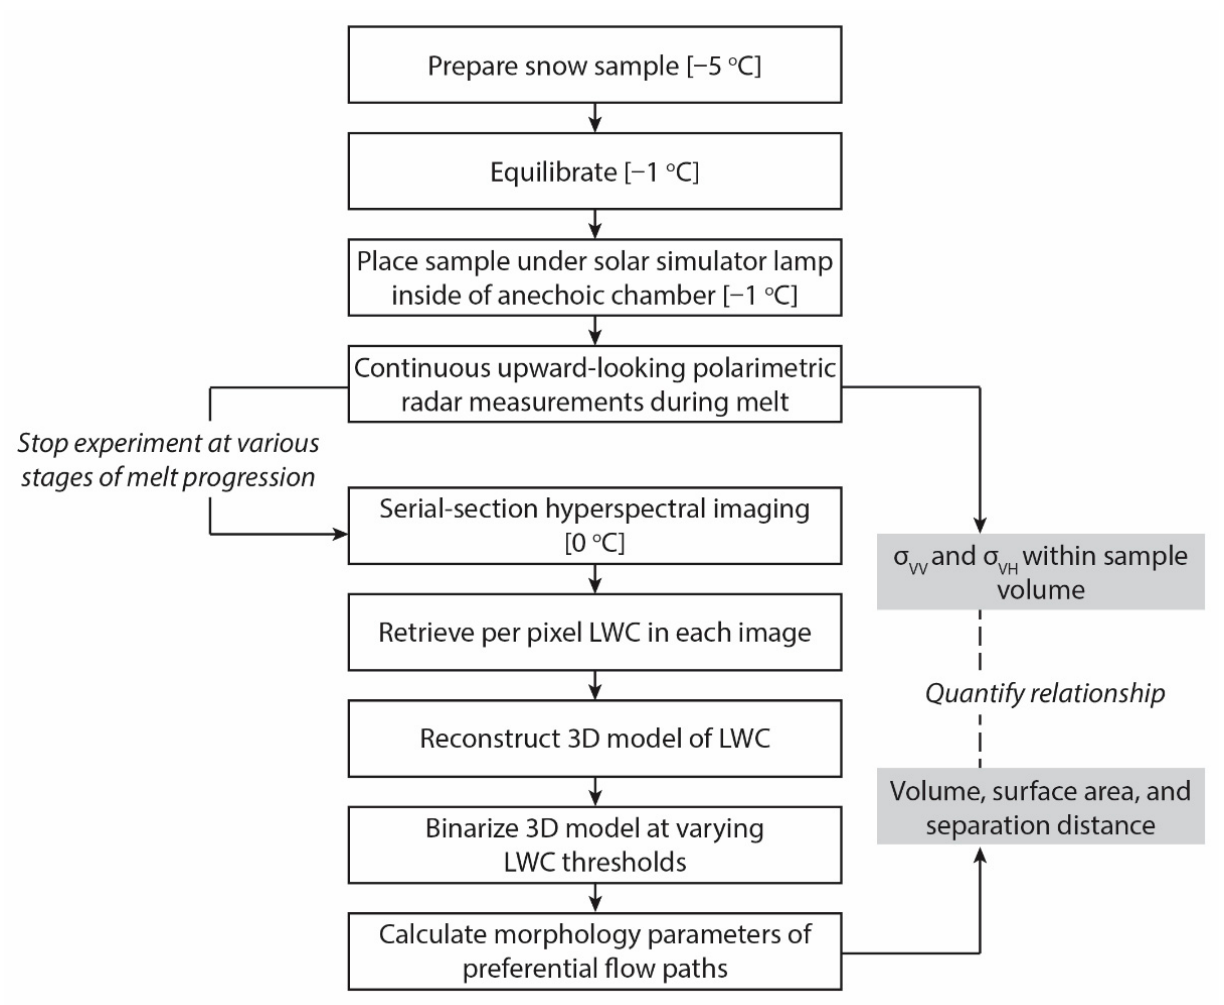
Figure 2. Laboratory experimental workflow. Table 1. Snow sample